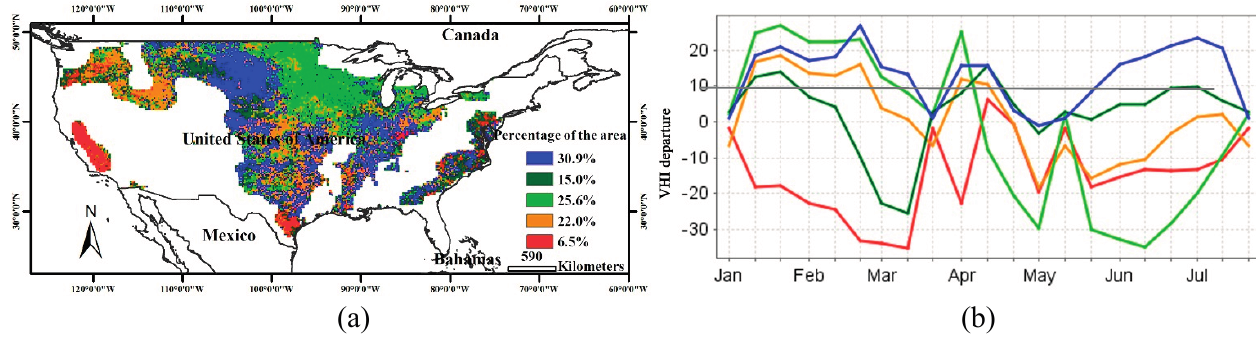
Figure 14. ( a ) The Spatial distribution of VHI departure cluster in the United States; ( b ) The VHI departure profiles associated with ( a ); the horizontal line denotes average